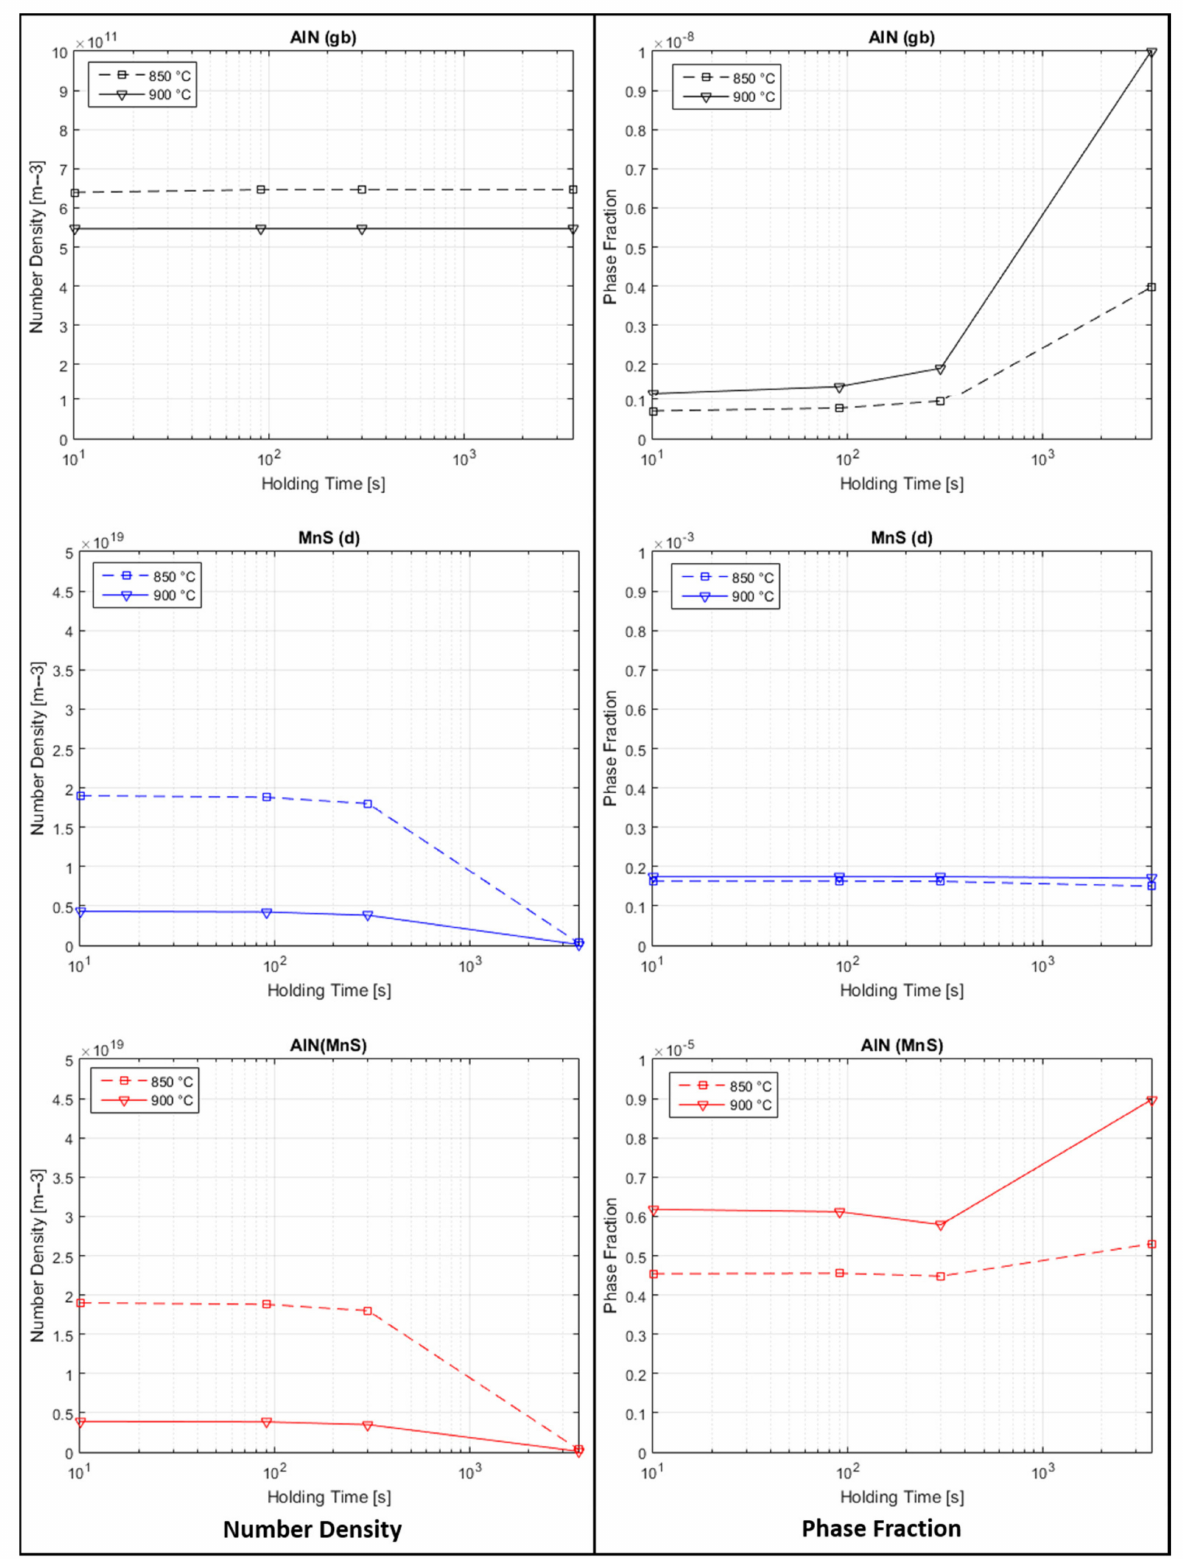
Figure 14. Results of number density and phase fraction simulations for AlN at grain boundaries, MnS at dislocations, and AlN at MnS for different temperatures and holding